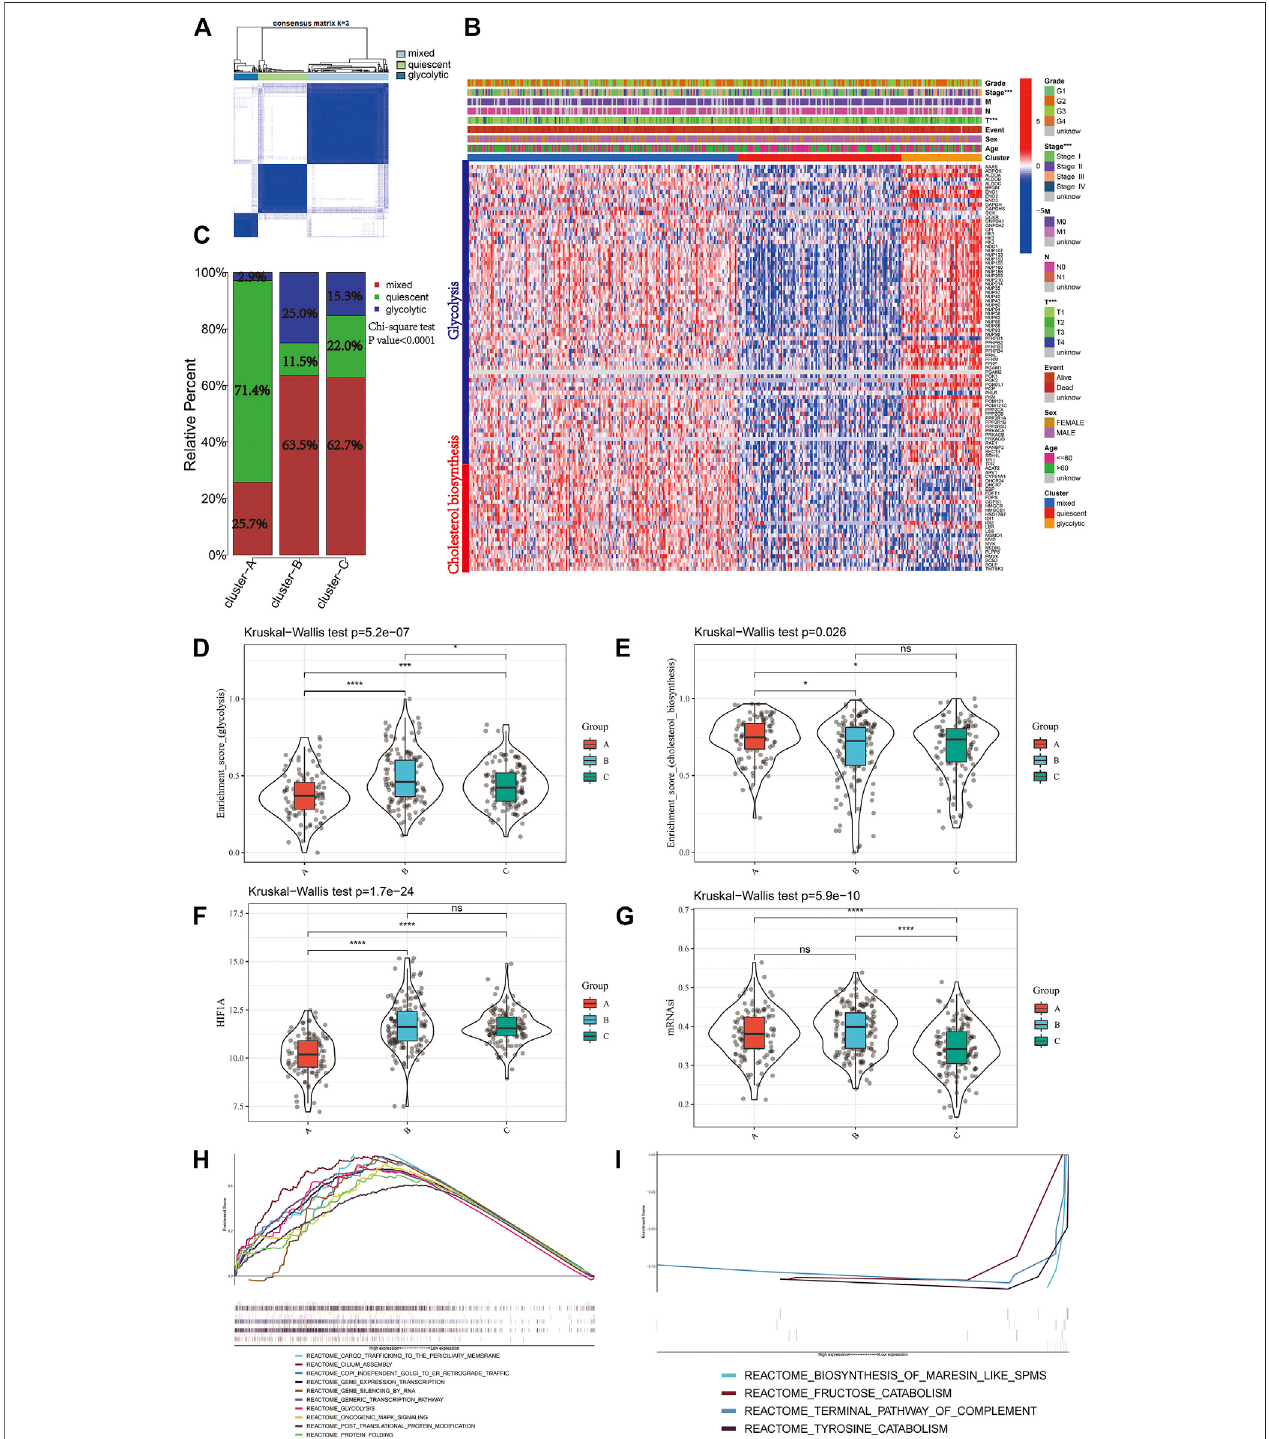
FIGURE 4 | Identify different metabolic subtypes (A) Consensus matrices of the TCGA cohort for k (cid:1) 3 (B) Unsupervised clustering of total 97 genes from the cholesterol biosynthesis and glycolysis gene sets in TCGA cohorts to classify patients into different subtypes (mixed, quiescent, and glycolytic). Grade, stage, gender, survival status and age were utilized as patient annotations (C) The proportion of metabolic subtypes in the three mitophagy subtypes. Mixed subtype, red; quiescent subtype, green; glycolytic subtype, blue. The enrichment score of glycolysis (D) and cholesterol biosynthesis (E) gene sets between the different mitophagy subtypes in TCGA LIHC (F) Differences in HIF1A expression level among three mitophagy subtypes in TCGA LIHC cohort (G) Differences in mRNAsi score among three mitophagy subtypes in TCGA LIHC cohort. The KruskalWallis test was used to compare the statistical difference between three subtypes. GSEA results enriched in cluster A (H) and cluster B (I) . The asterisks represented the statistical p value (* p < 0.05; ** p < 0.01; *** p < 0.001; **** p < 0.0001).